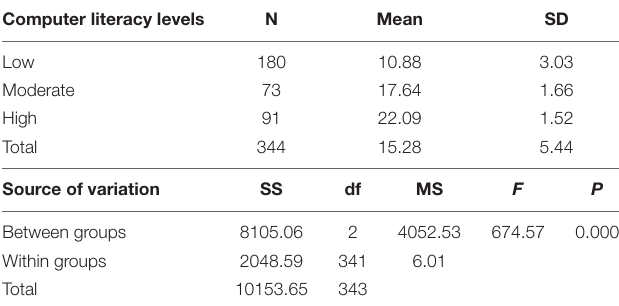
TABLE 5 | One-way analysis of variance of the mean difference in ICT deployment by academic staff based on their computer literacy levels. Computer literacy levels